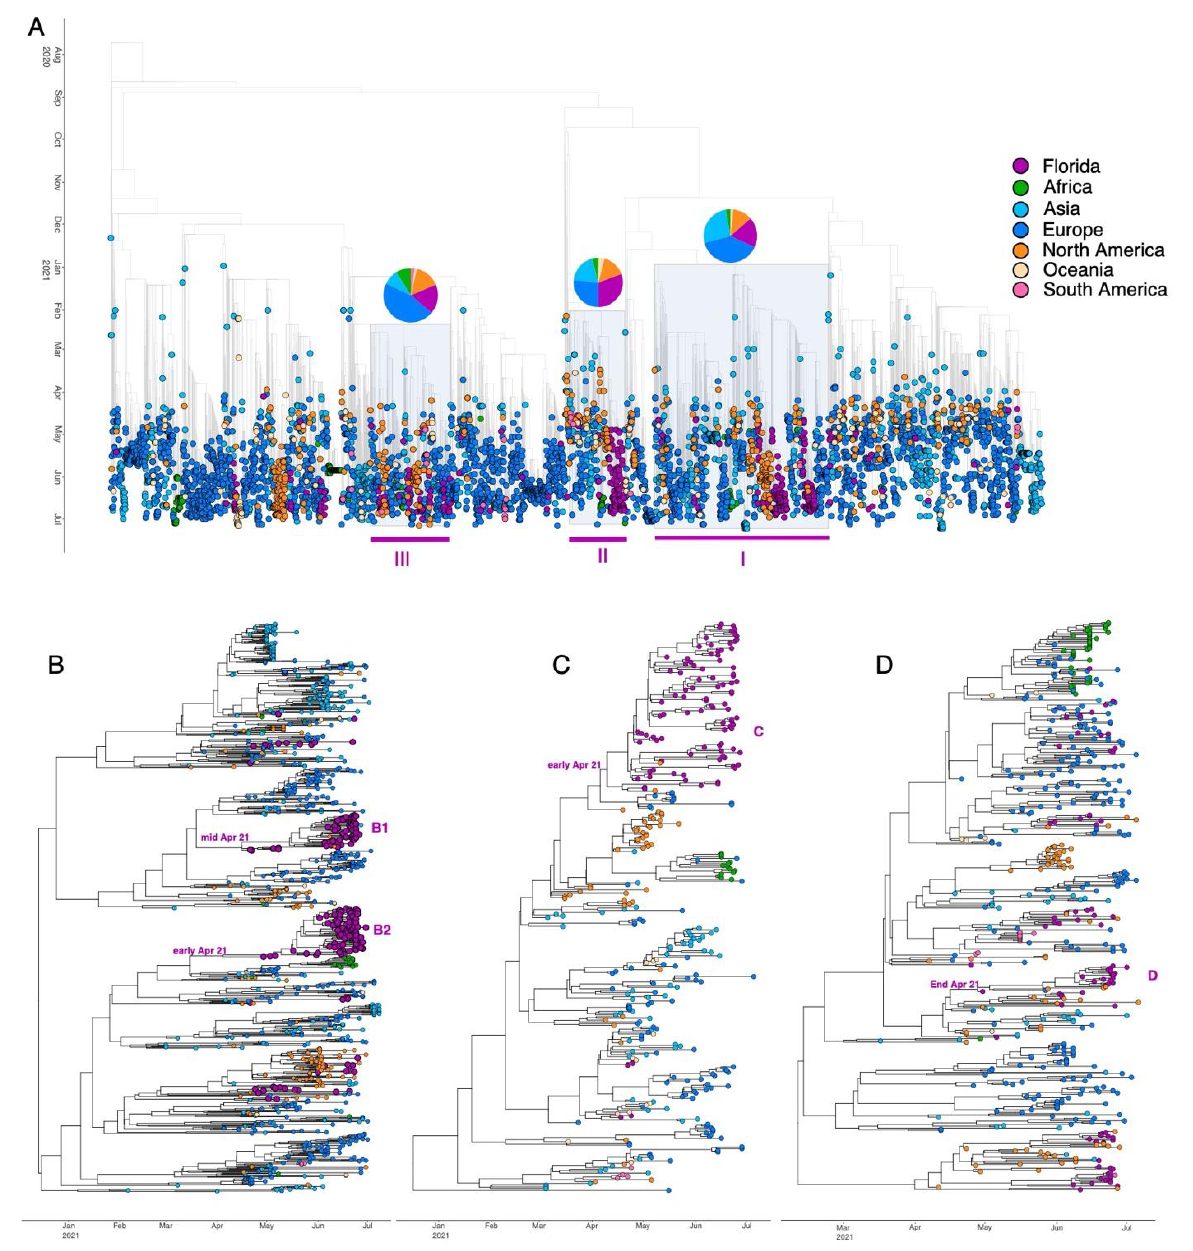
Figure 4. Time-resolved maximum-likelihood trees containing high-quality Delta SARS-CoV-2 near-